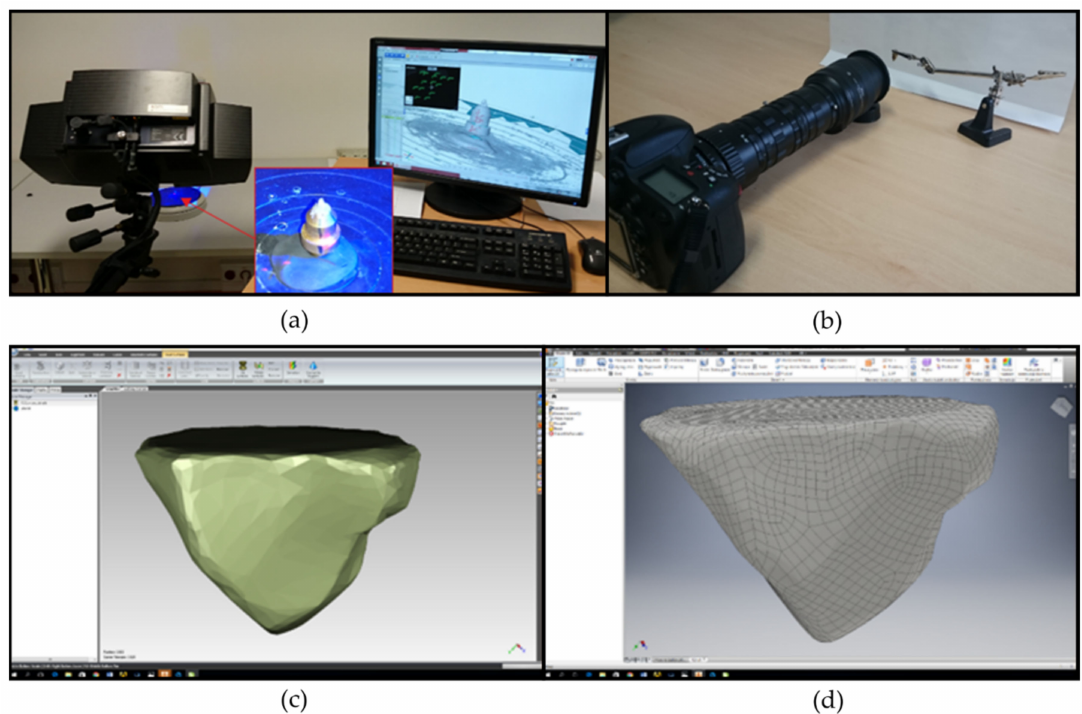
Figure 2. Methodology of abrasive grains shape reconstruction: ( a ) 3D scanning, ( b ) taking the macrotopography, ( c ) processing of the point clouds in the Geomagic software, ( d ) analysis of the geometric properties in Autodesk Inventor software.